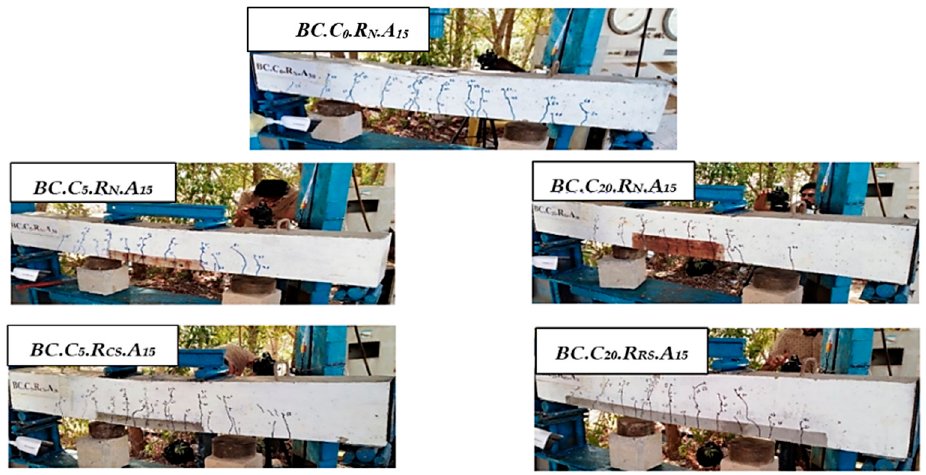
Figure 7. Cracking patterns at failure for specimens in Group B.